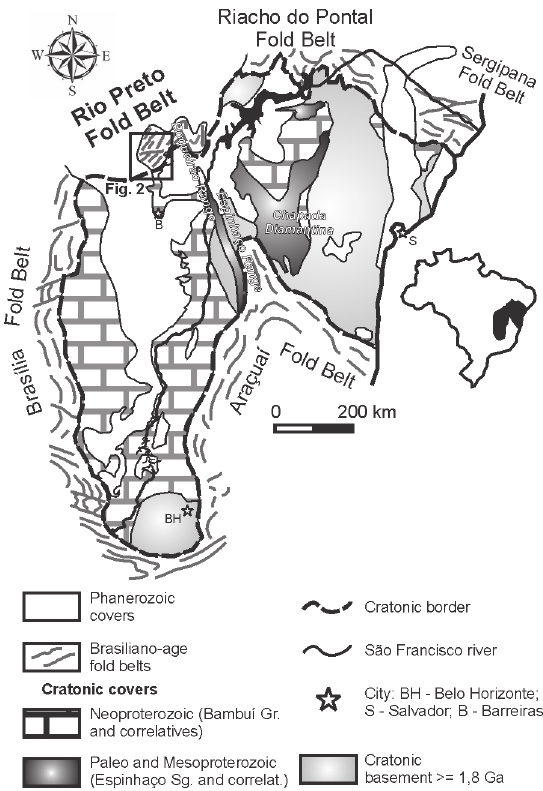
Figure 1 - The São Francisco craton and surrounding fold belts. The rectangle indicates the location of Fig. 2. Modified from Alkmim